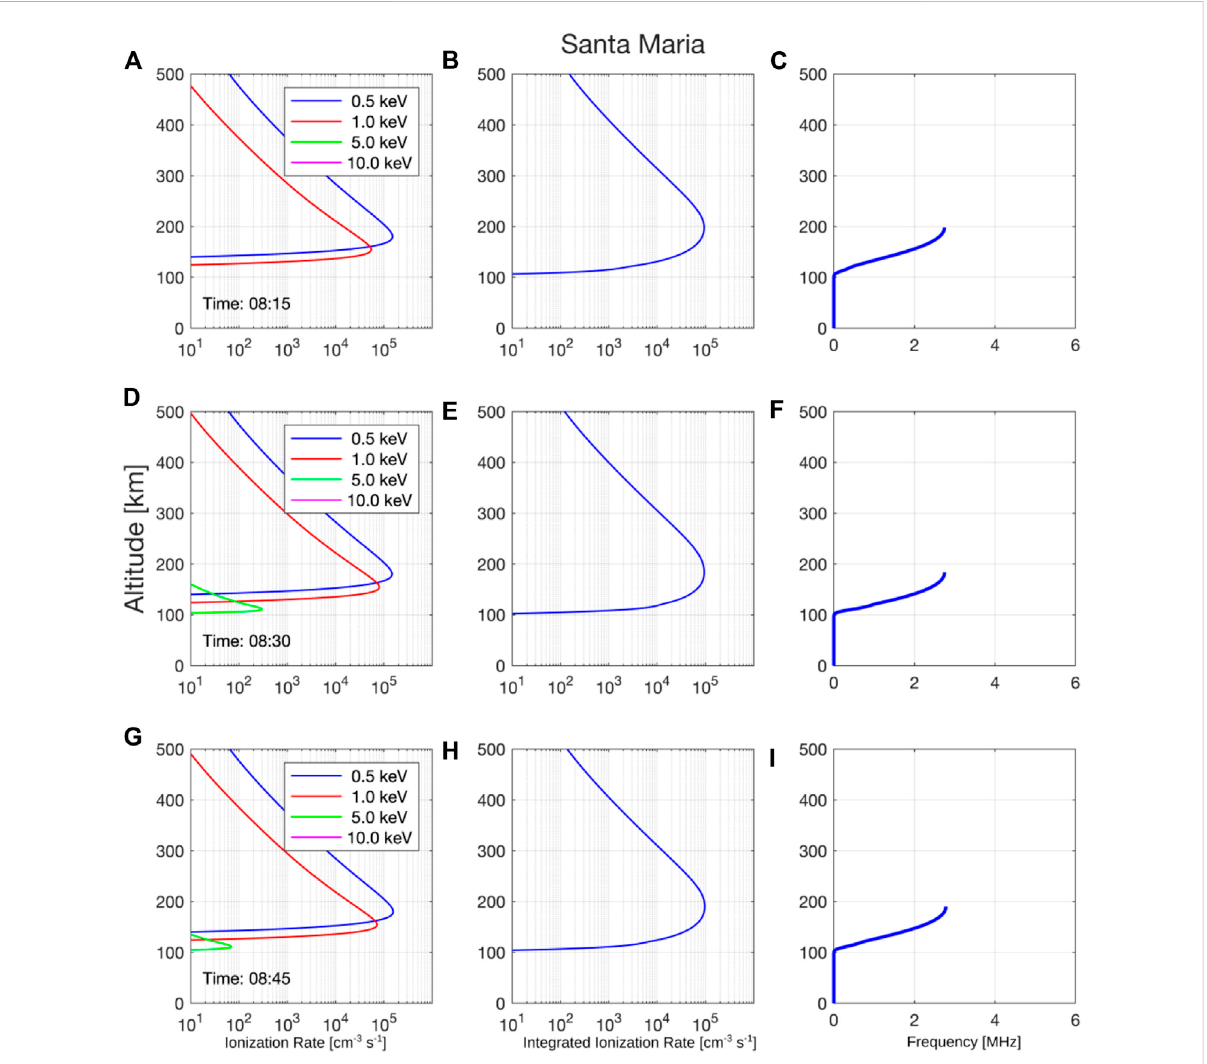
FIGURE 11 Ionization rate altitude pro fi les panels (A,D,G) , ionization rate altitude integrated panels (B,E,H) and frequency range altitude panels (C,F,I) consideringthesecondconjunctionforSantaMariastation.ThetotalincidentenergyofelectronsispresentedinFigure10(toppanel).Theionization rate is obtained from empirical model (Fang etal., 2010) considering the total incident energy of electrons presented in Figure 10 (top panel)and the height scale presented in Figure 15 (top